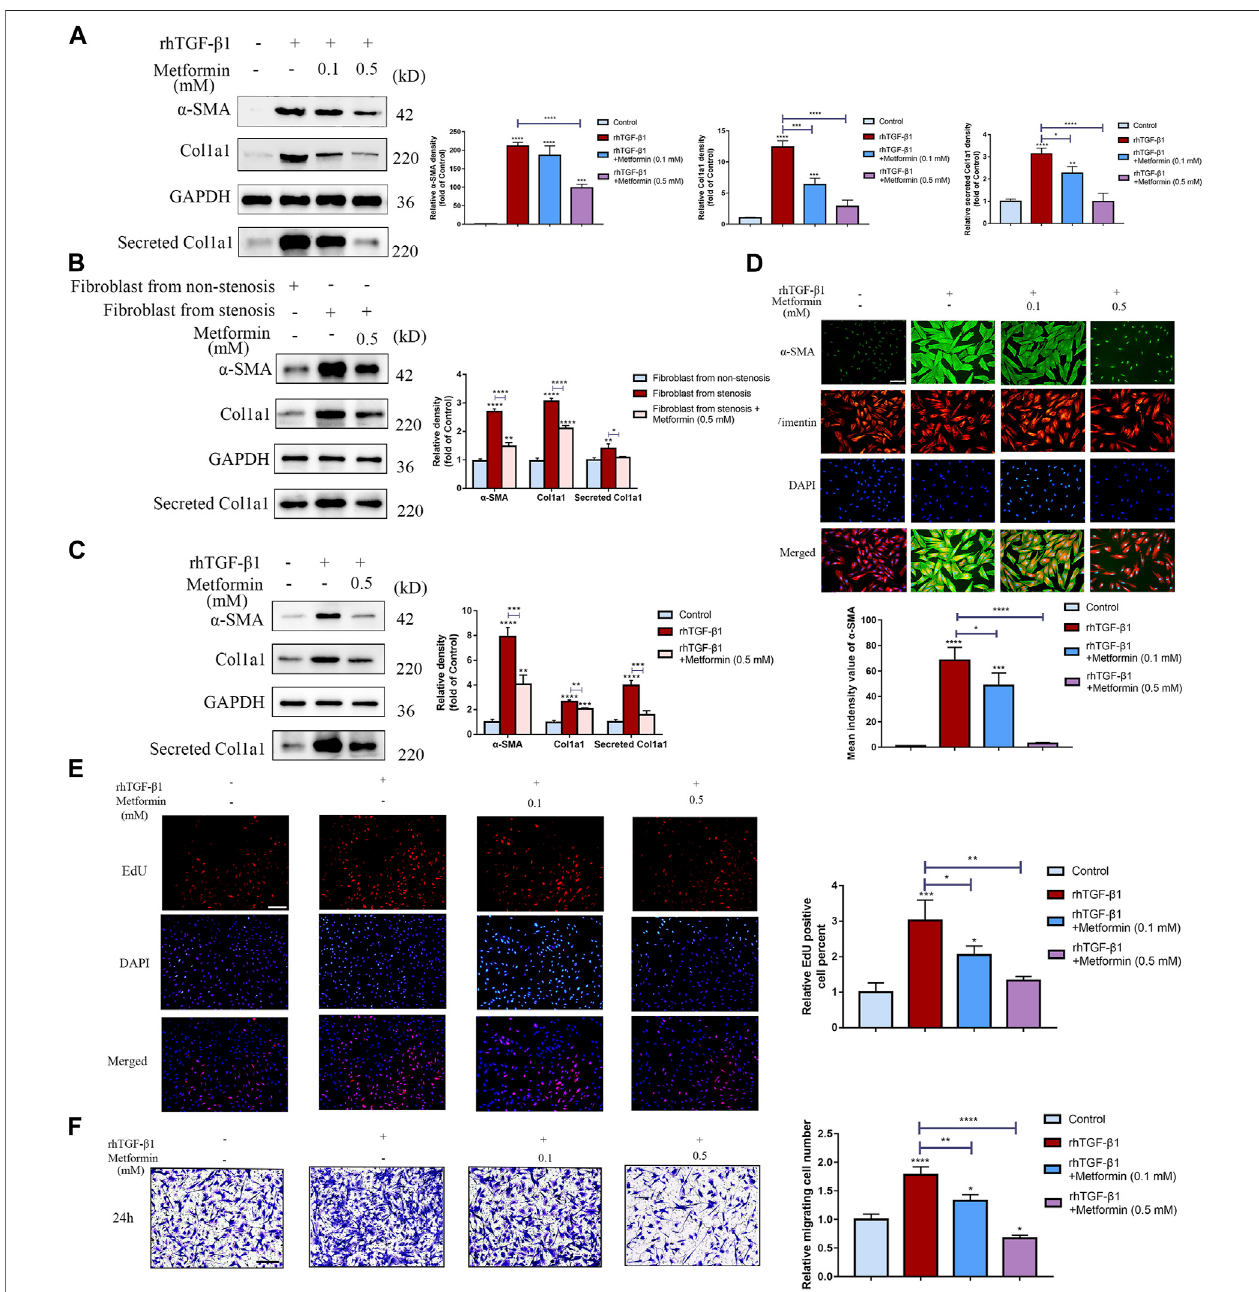
FIGURE 5 | Metformin dose-dependently attenuates TGF- β 1-induced collagen production and proliferation in cultured human colon fi broblasts. (A) Protein expressions of Col1a1 and α -SMA in CCD-18Co cells induced by TGF- β 1 or metformin, and Col1a1 in supernatant secreted by CCD-18Co cells. Relative densitometry values are indicated beside blots as ratios relative to GAPDH (B) Protein expressions of Col1a1, α -SMA and Col1a1 secretion in primary intestinal fi broblasts treated by metformin. Relative densitometry values are indicated beside blots as ratios relative to GAPDH. (C) Protein expressions of Col1a1, α -SMA and Col1a1 secretion induced by TGF- β 1 or metformin in primary intestinal fi broblasts isolated from non-stenosis. Relative densitometry values are indicated beside blots as ratios relative to GAPDH. (D) CCD-18CocellsstimulatedbyTGF- β 1ormetforminwerestainedwithprimaryantibodiesagainstVimentinand α -SMA.Representativeimmuno fl uorescent- stained images of Vimentin and α -SMA expression in different groups are shown. (E) Proliferation of human colon fi broblasts treated with or without metformin was demonstrated by EdU incorporation in response to 2 ng/ml rhTGF- β 1. Representative IF images are shown. (F) Cell motility was monitored by Transwell tests ( n = 3 independent experiments). Representative microscopy pictures (left) and quanti fi cations of migrating cells (right) are shown (* p < 0.05; ** p < 0.005; *** p < 0.0005; **** p < 0.0001). Means ± SD. Scale bars, (D) 100 μ m; (E,F) 200 µm.